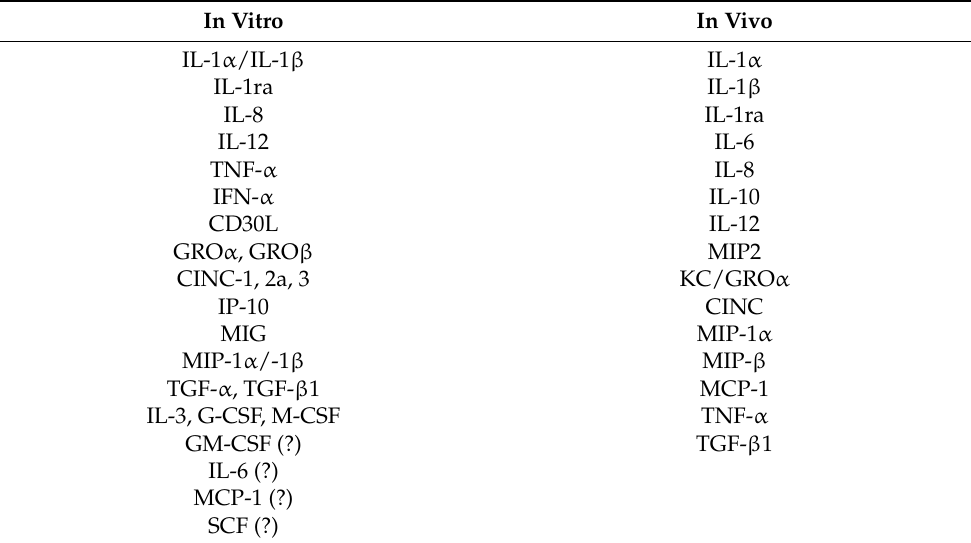
Table 2. The cytokines/chemokines/growth factors expression in normal human PMNs in vitro and in vivo *. In Vitro In